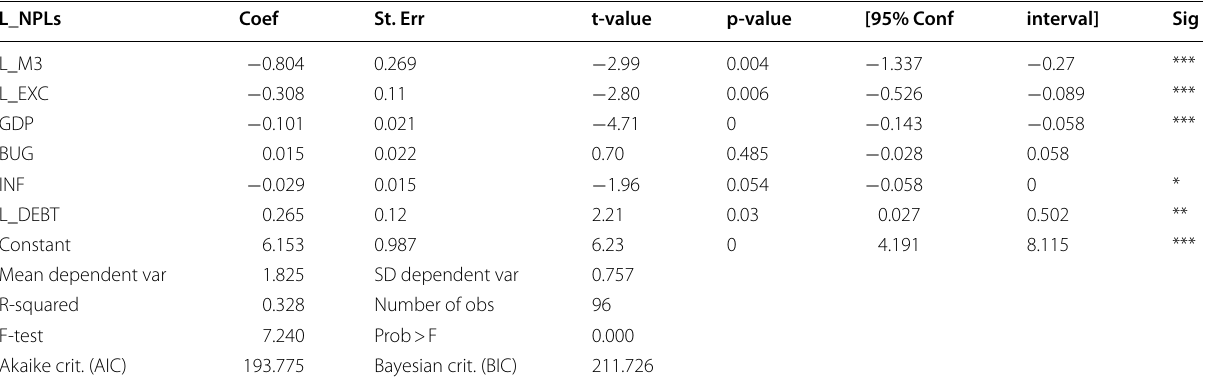
Table 7 Pooled OLS estimation